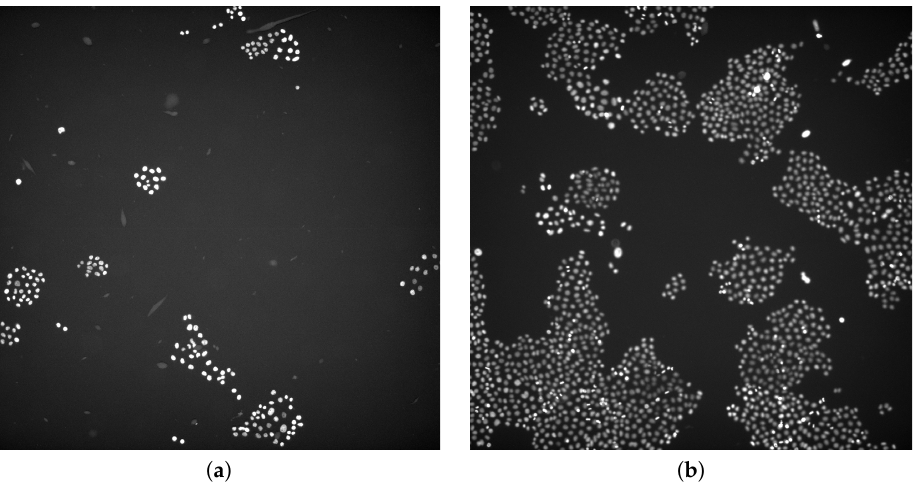
Figure 1. ( a , b ) Examples of the analyzed microscopy fluorescence images provided by the Department of Biochemistry of the VU. The images were displayed by automatically adjusting the brightness and contrast according to an histogram-based